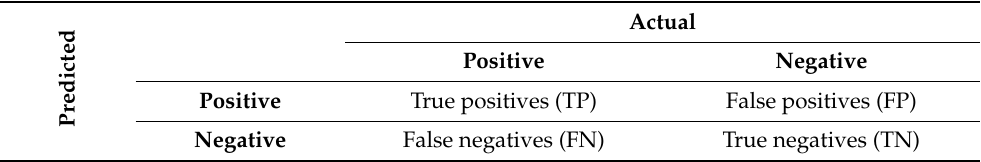
Table 1. Confusion or error matrix as a metric of prediction